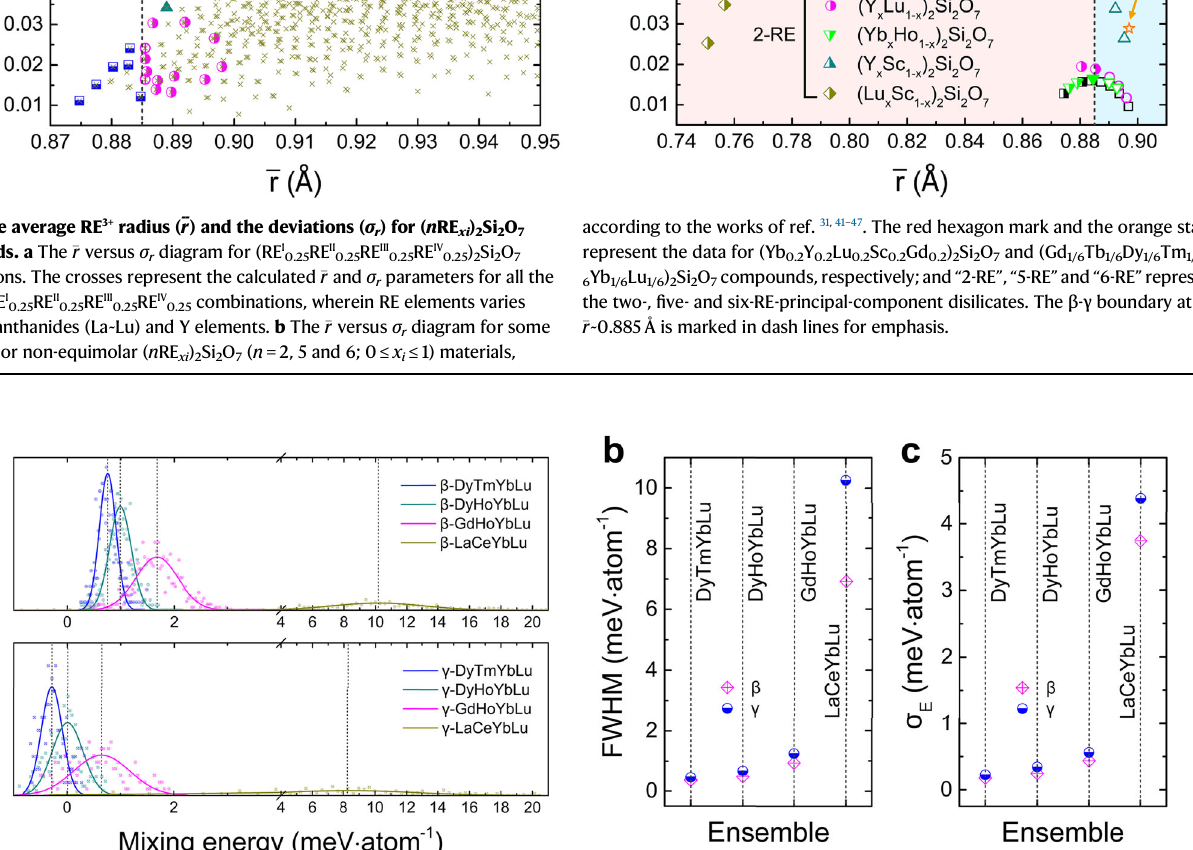
Fig. 5 | Statistical parameters for the Gaussian- fi tted mixing energy ( E i ) dis- tribution spectrum for β -type and γ -type ensembles. a The distribution of mixing energy ( E i ) for all the studied ensembles. The scatters are the normalized density for E i analyzed by breaking the entire range of E i valuesinto smallintervals Δ E , and then adding up the number of E i that falls with each interval; herein,